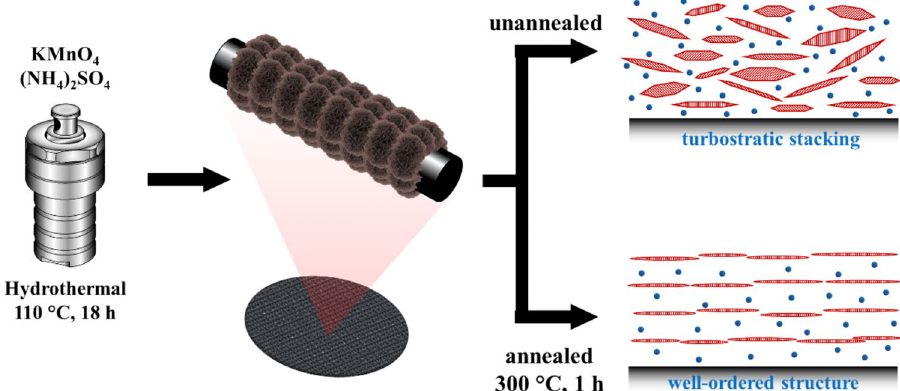
Figure 3. Formation of orthorhombic δ -MnO 2 via hydrothermal method and the transition from turbostratic stacking to well-ordered structure of orthorhombic δ -MnO 2 via annealing. The red hexagonal disk and blue circles correspond to the sheet-like MnO 2 and surface water, respectively.